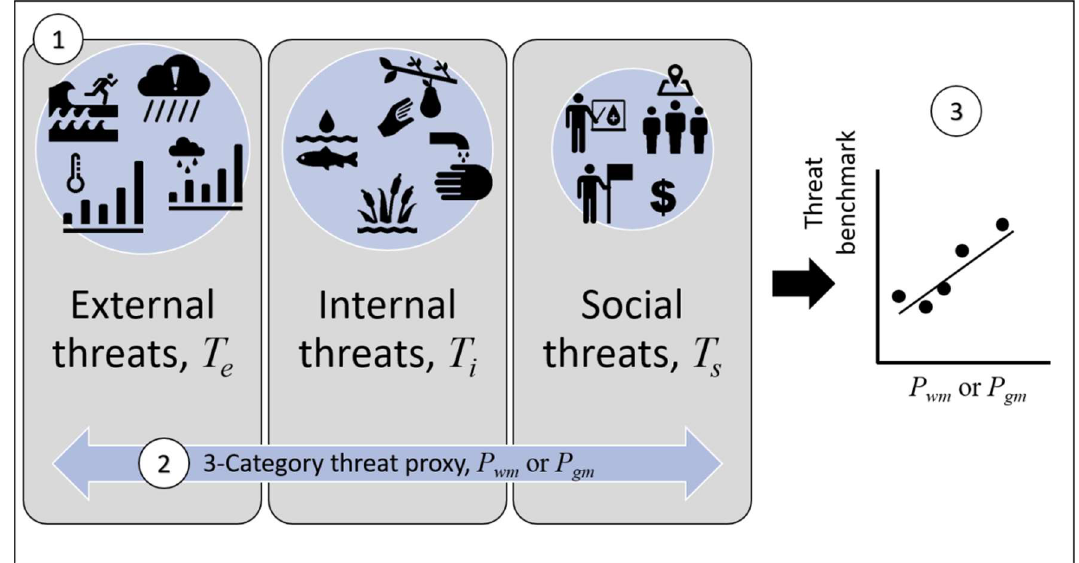
Figure 2. Method for developing three category proxies for benchmark freshwater ecosystem service threats: (1) averaging of proxies within each category; (2) aggregation of proxies from the three categories, (i) external (regional hydro-climatic), (ii) internal (land use and watershed management-related), (iii) social (wealth and governance related); and (3) building benchmark-proxy relationships through regression analysis .